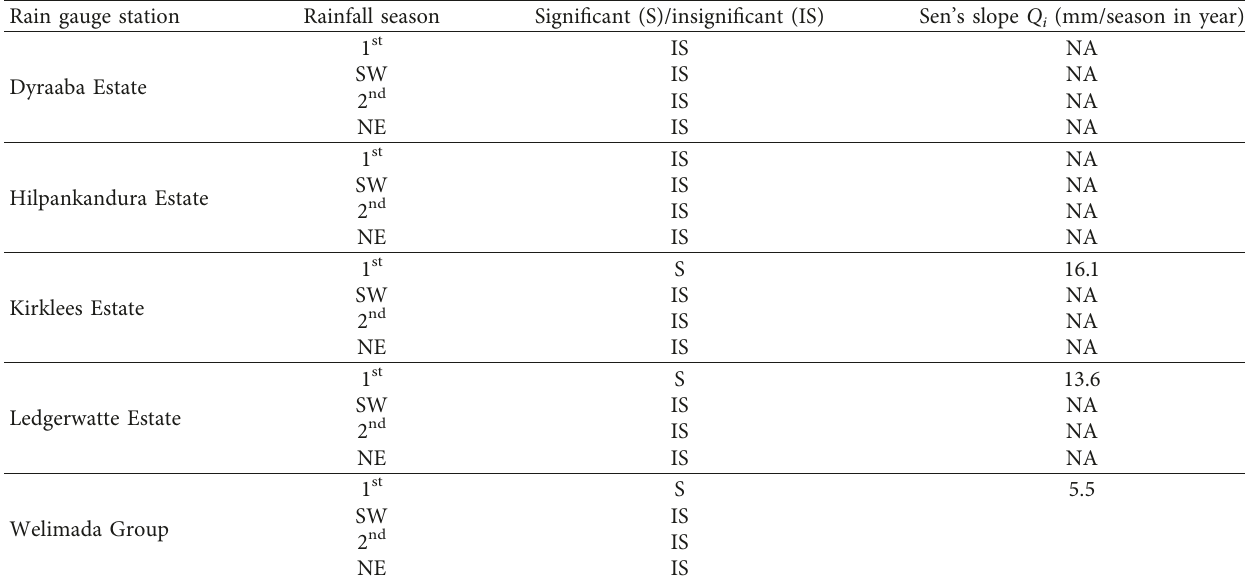
Table 2: Results of Mann–Kendall’s test and Sen’s slope estimator test for